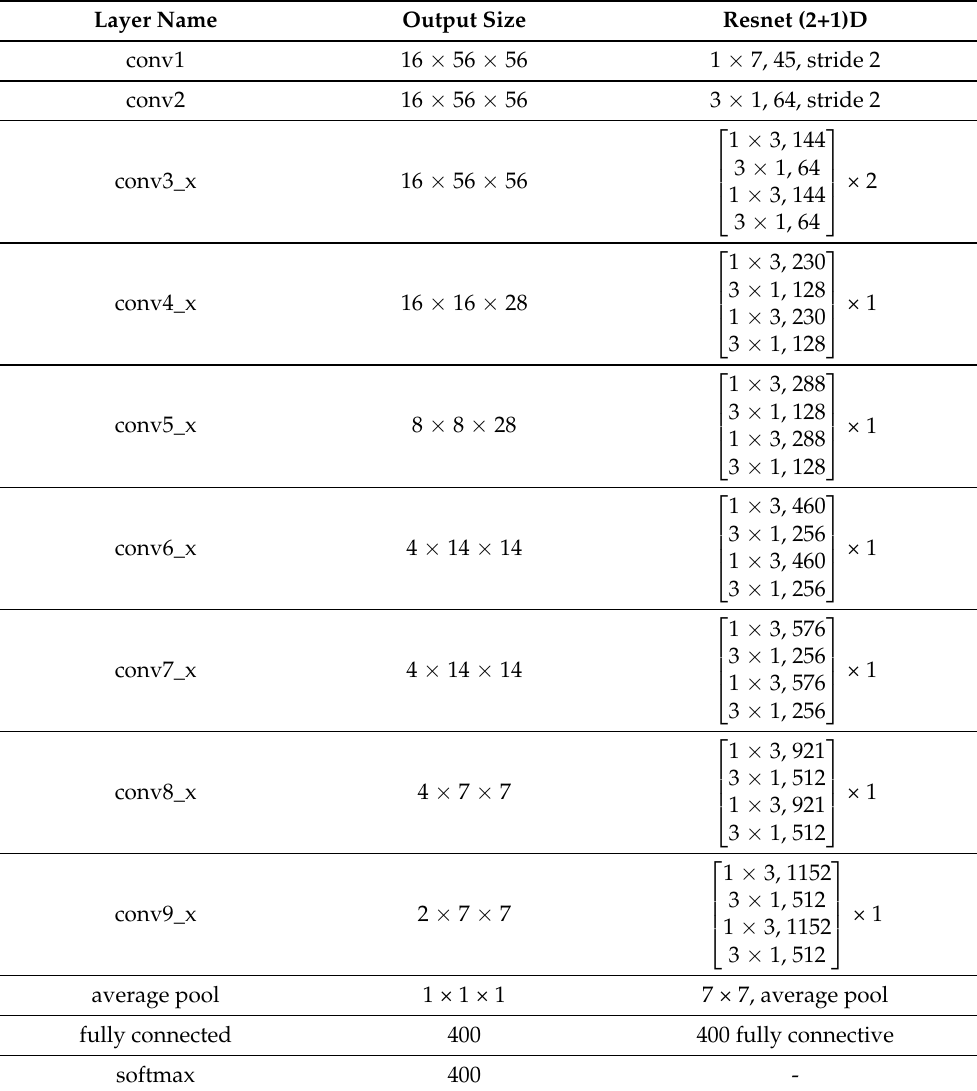
Table 4. Resnet (2+1)D’s